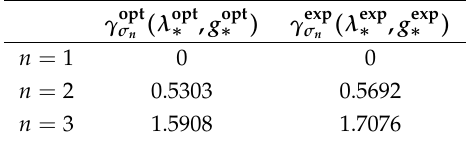
in d = 3 in the full-fledged Einstein–Hilbert n